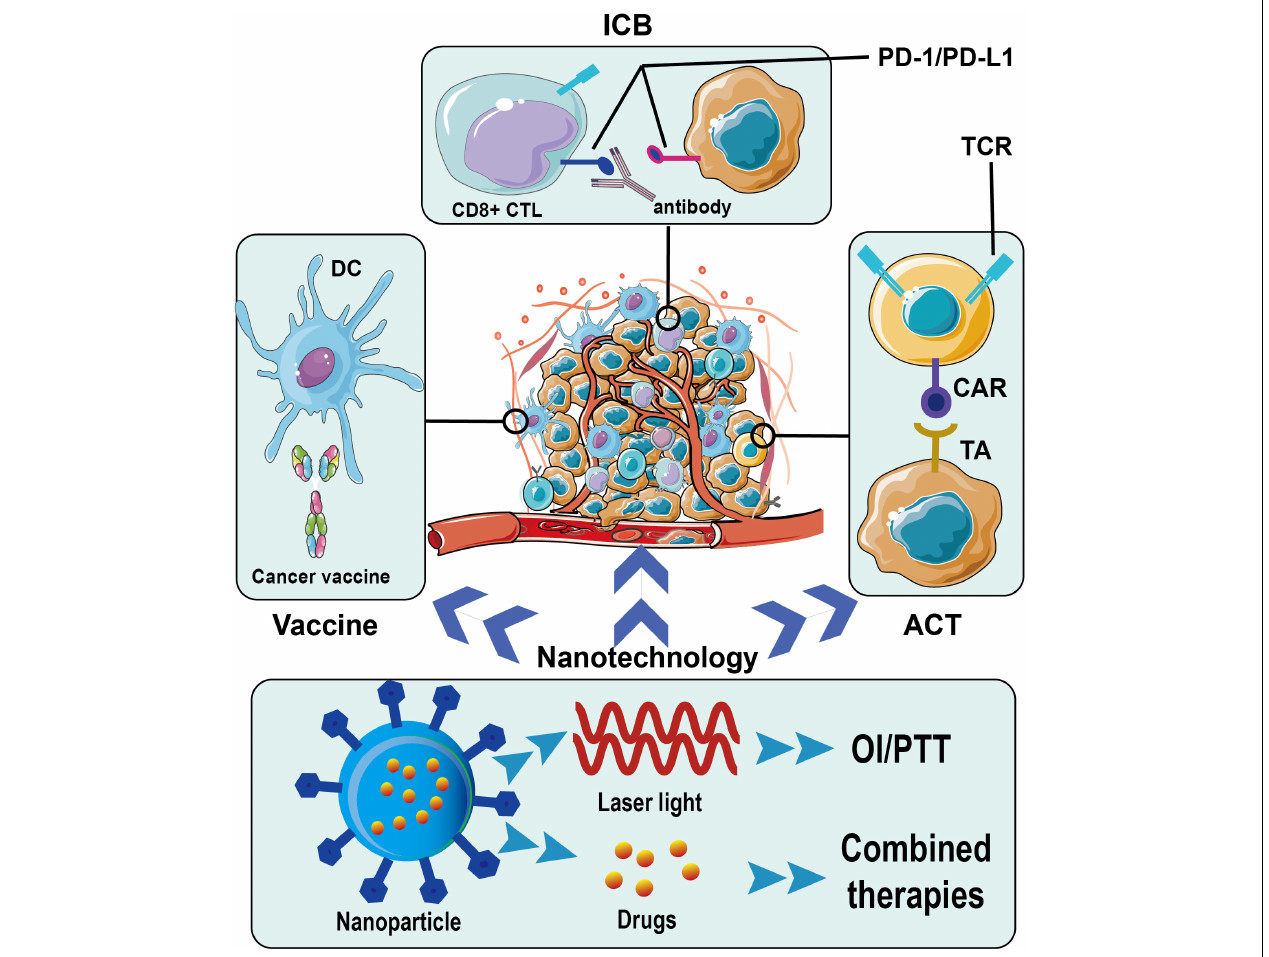
FIGURE 1 | Immunotherapy for breast cancer and application of nanotechnology. ICB, immune checkpoint blockade; PD-1, programmed death protein 1; PD-L1, programmed death protein-ligand 1; DC, dendritic cell; CTL, cytotoxic T lymphocyte; TCR, T cell receptor; CAR, chimeric antigen receptor; TA, tumor antigen; ACT, adoptive cell therapy; OI, optical imaging; PTT, photothermal